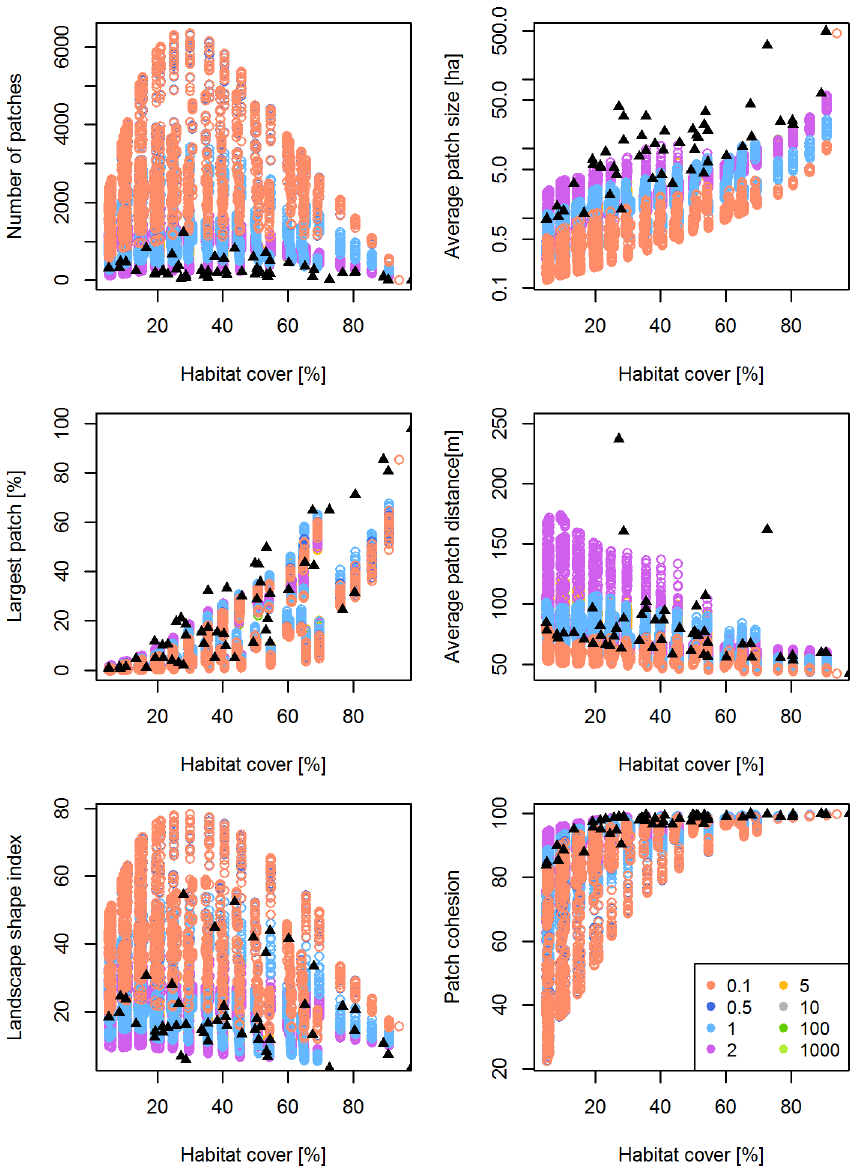
Figure 5. Attributes of the landscapes generated by Dinamica (version 4). Generated landscapes are illustrated in colored circles, and compared to 50 real landscape maps as in Figure 2. Results illustrate Dinamica in the most complex model version 4. Colors represent values of the parameter patch generation parameter 3 , the parameter that controls patch isometry. For model versions 1–3 see Appendix S1.